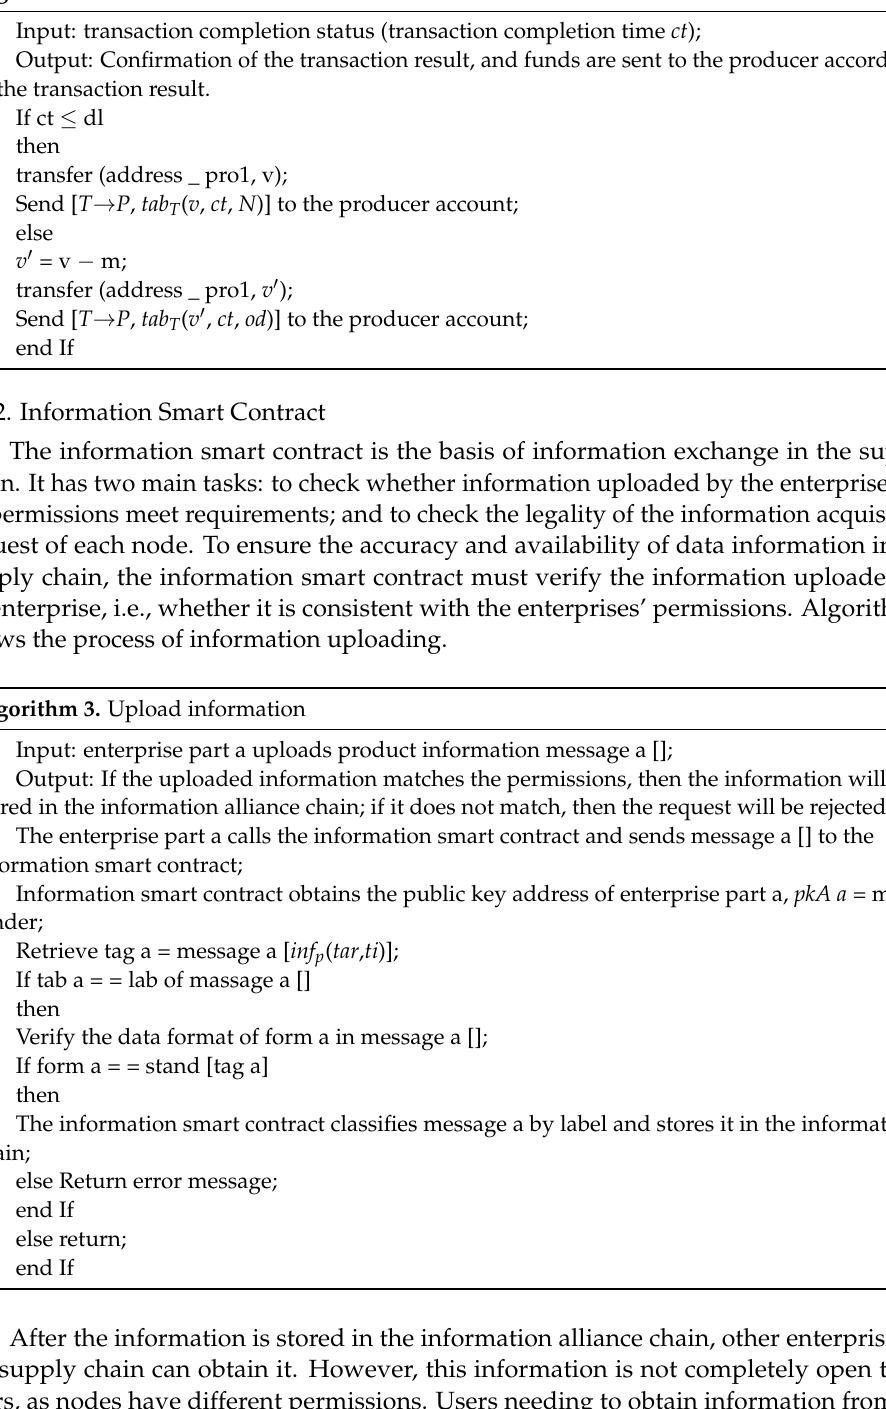
Algorithm 2. Transaction result identification